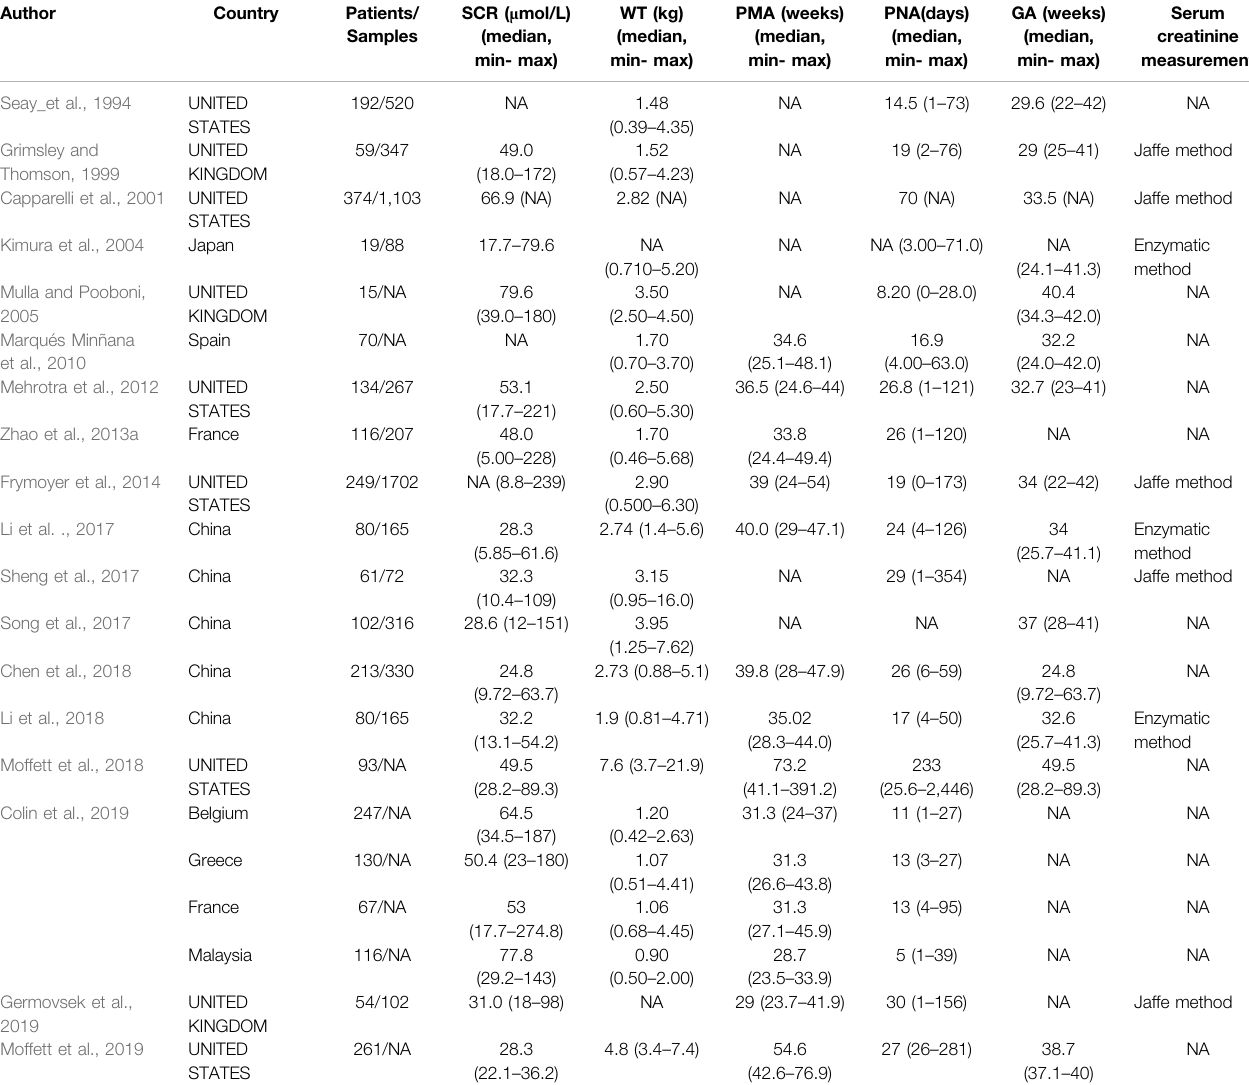
TABLE 1 | Summary characteristics of published population pharmacokinetic studies of vancomycin in